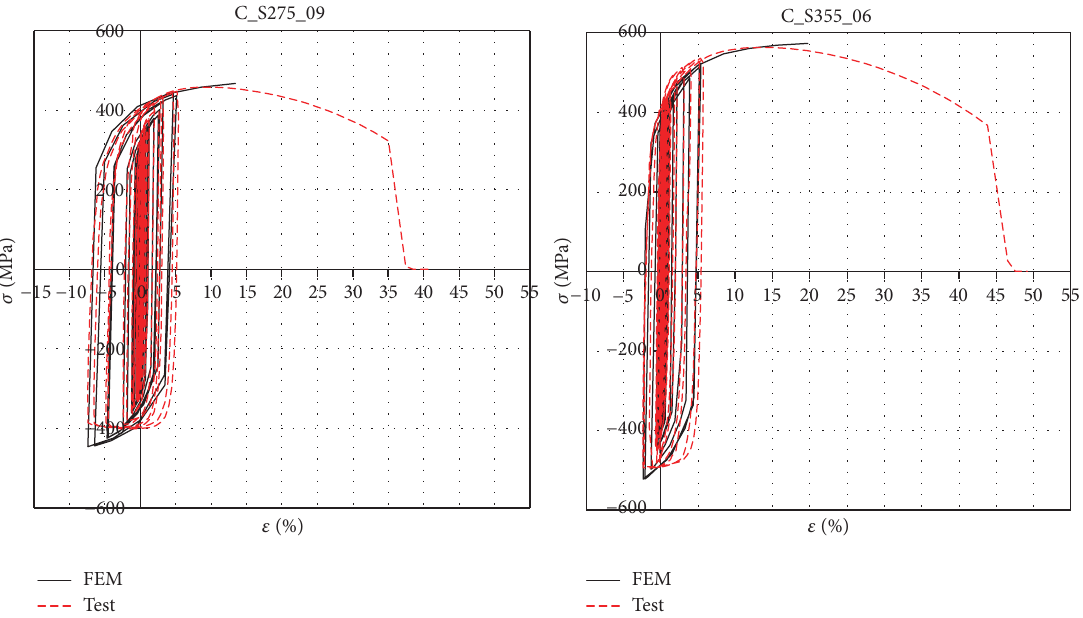
Figure 8: Comparison of the numerical simulation and experimental test results for the calibrated